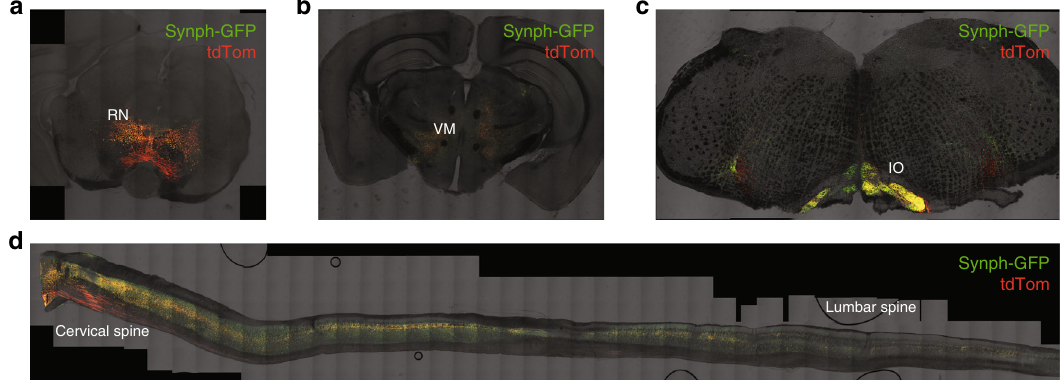
Fig. 5 Vglut2-positive cells project to thalamic, inferior olive and spinal cord areas. a Example images of synaptophysin-GFP-td-Tomato expression in the RN of Vglut2-CRE mice ( n = 4 mice). b Coronal view of Vglut2- RN innervation in the thalamus. c Coronal section of the brainstem. d Sagittal view of